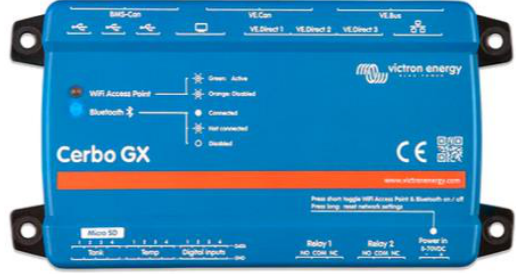
Figure 11. Cerbo GX Controller.